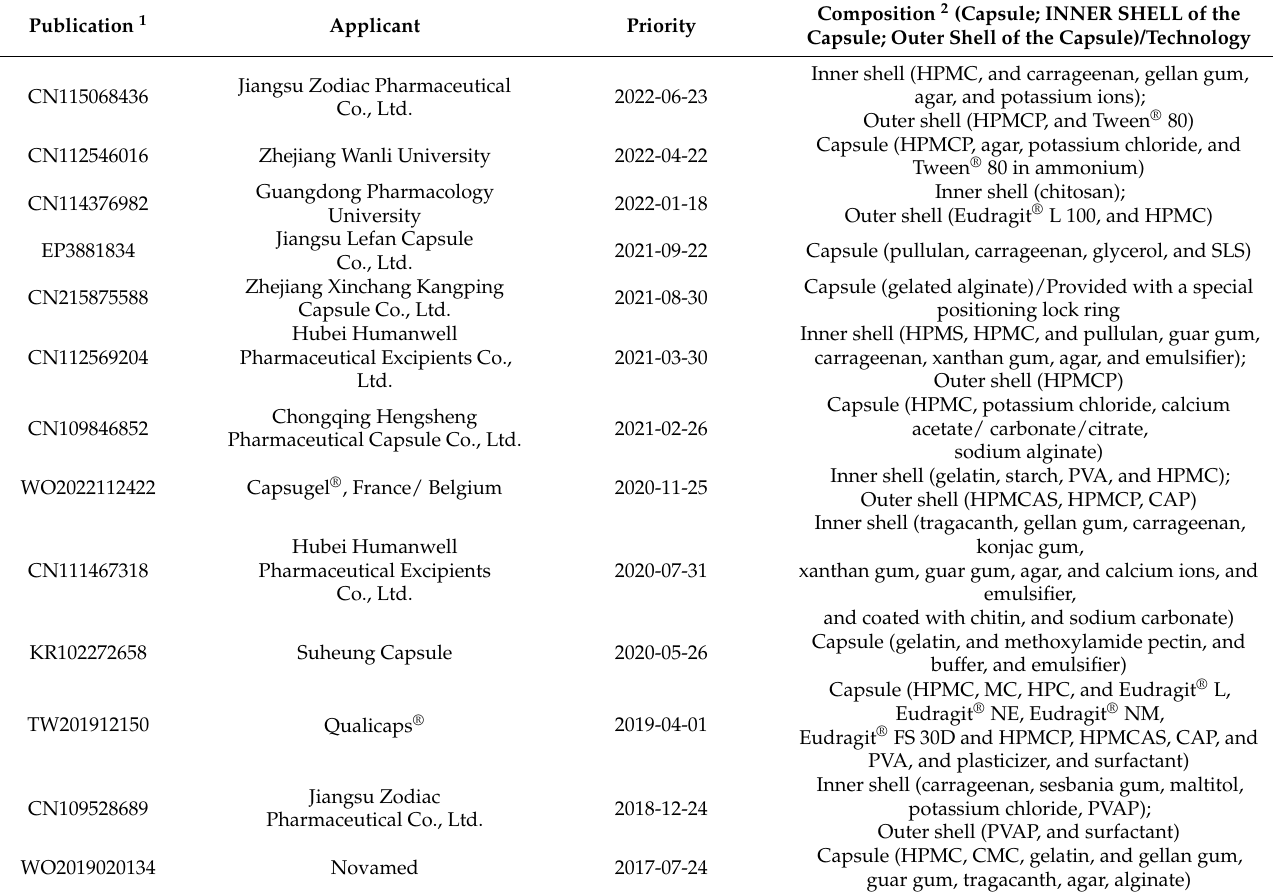
Table A1. Summary of inventions of enteric capsules between 1942 and